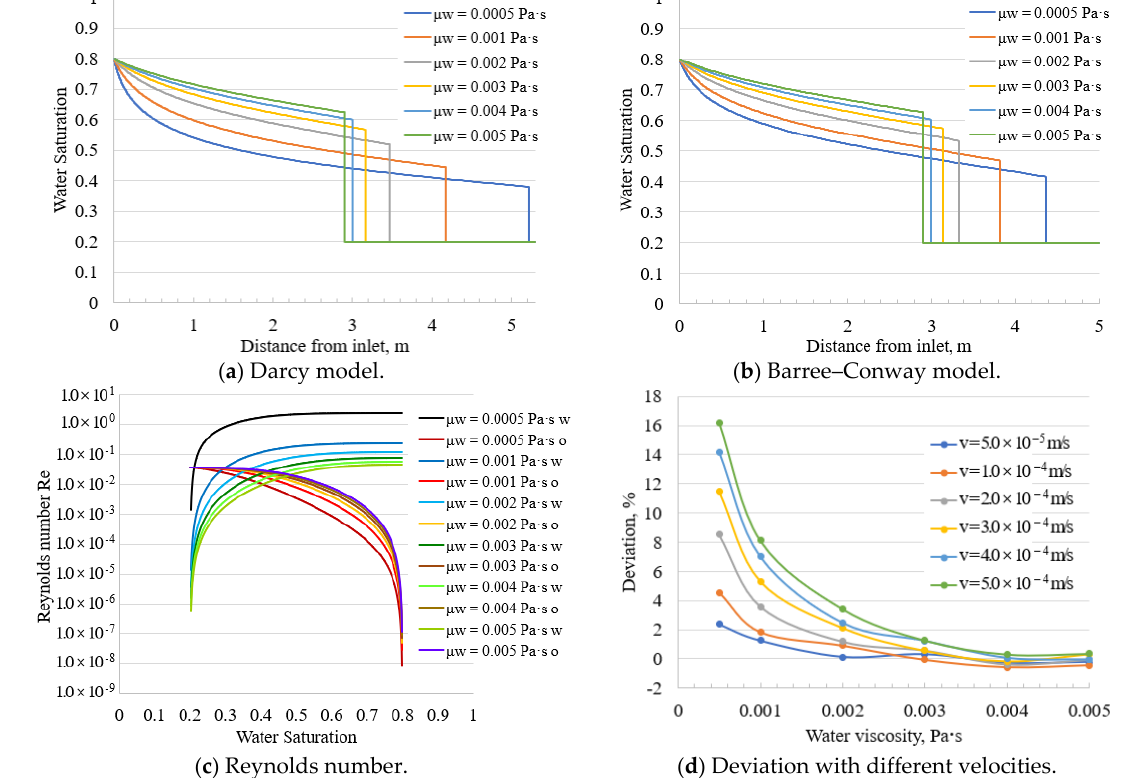
Figure 11. Comparison of Darcy model versus Barree – Conway model for different water viscosities.